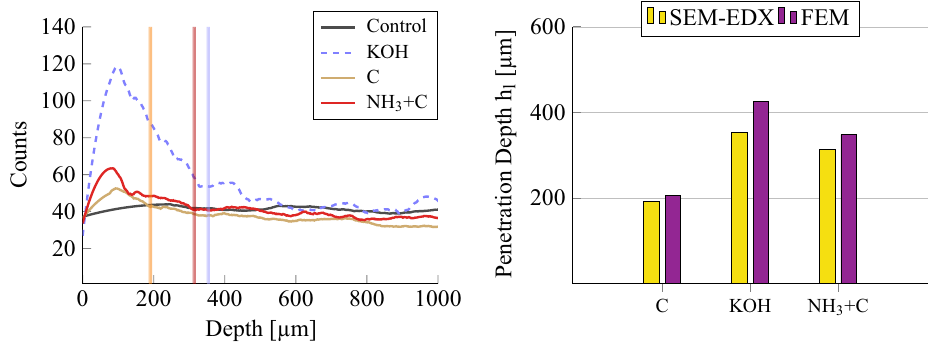
Figure 5. Left: Semi-quantitative line profiling of potassium (K) analyzed with SEM-EDX on plates subject to potassium-based treatments (i.e. involving KOH and C). The lines represent the potassium concentration evaluated at different depths while colored regions highlight the feasible limits of interaction between the wood and the different treatments. The limits were estimated by fitting a bilinear model to each profile decay; Right: Comparison between the penetration depths estimated from SEM-EDX profiles (yellow bars) and the mean values of the preferential depth ranges found through FE analysis (violet bars). The analysis is limited to plates subject to potassium-based